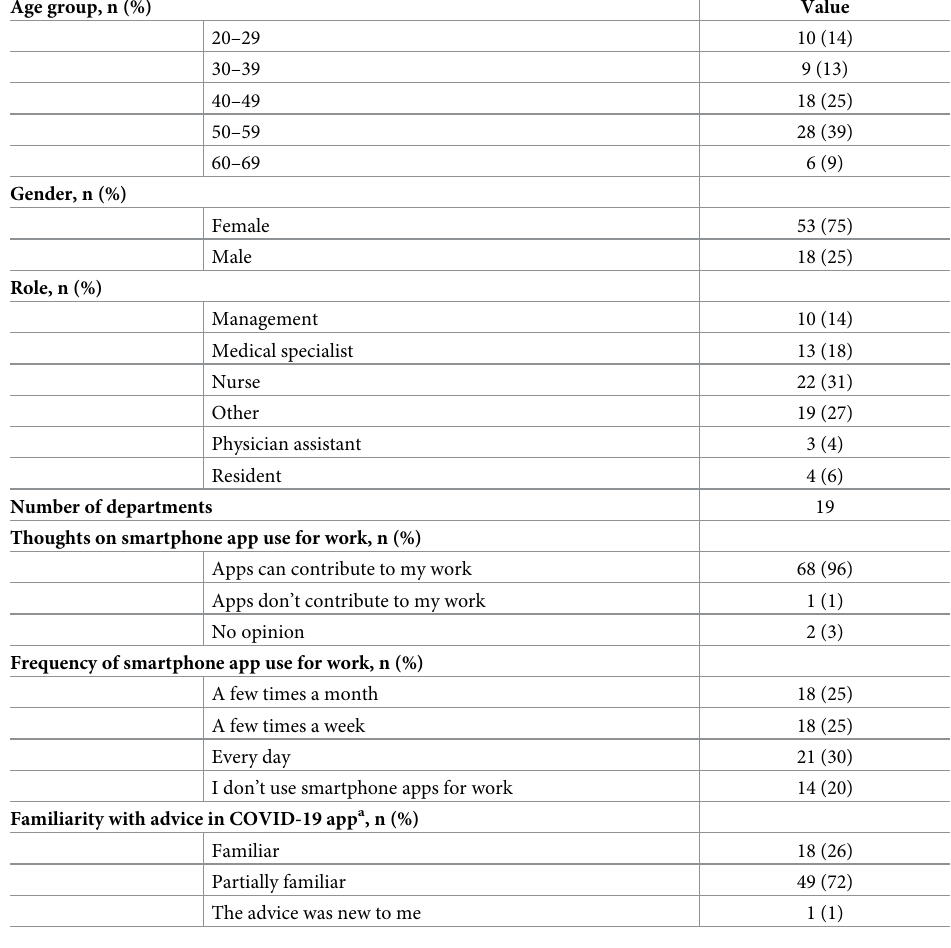
Table 3. Characteristics of questionnaire respondents (N = 71).